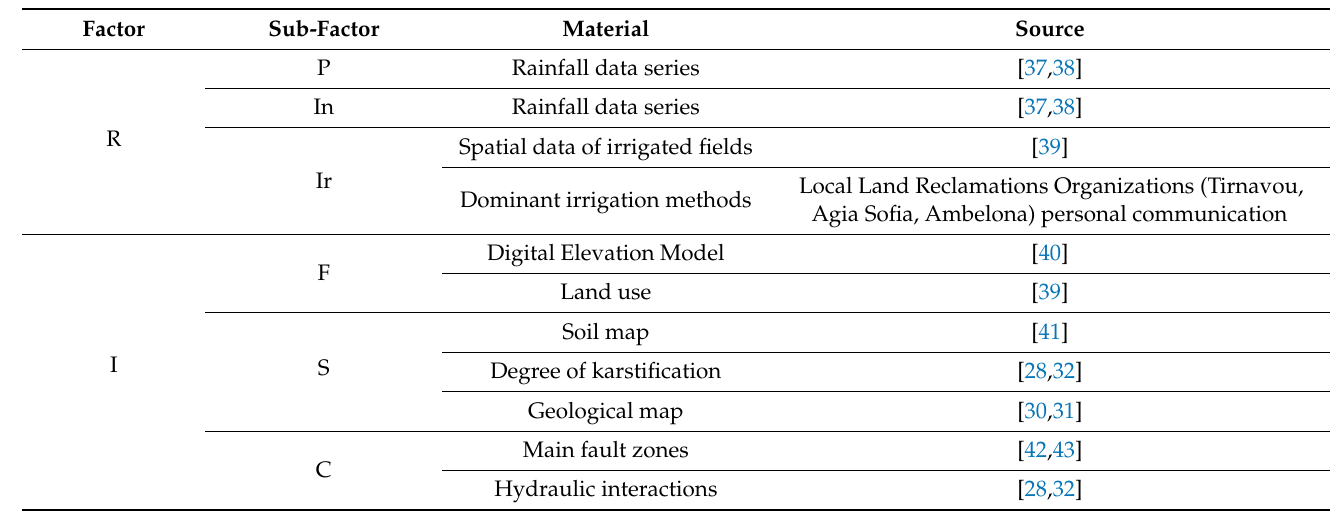
Table 1. Aggregate data used for RIVA method implementation in Tirnavos basin.